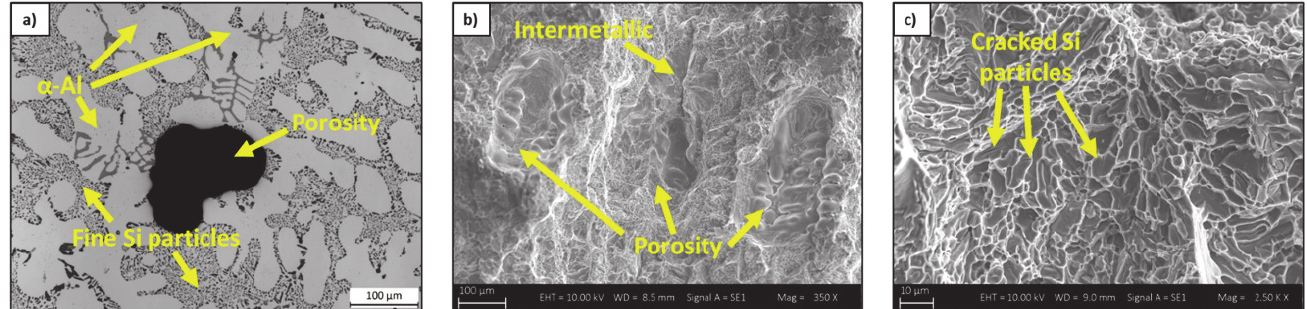
Figure 8: T6 heat treated specimen: (a) microstructure at high magnification by optical microscopy; (b-c) fracture surface by scanning electron microscopy.